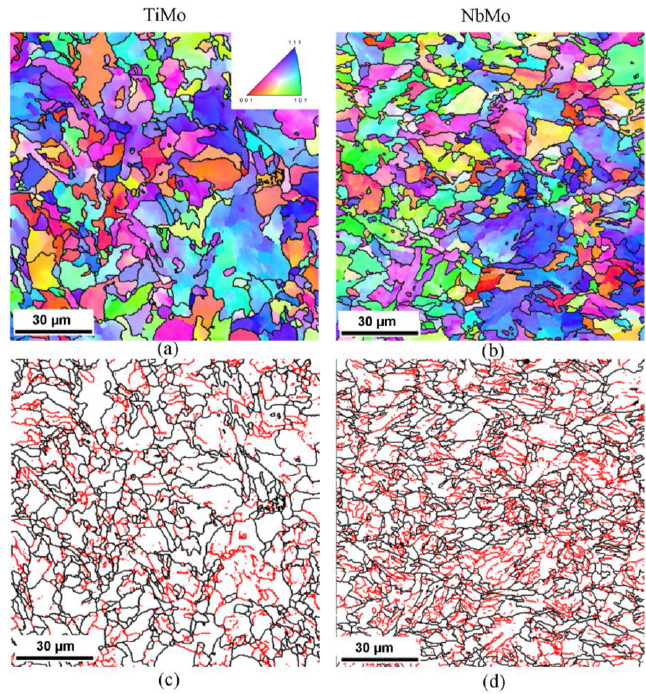
Figure 2. ( a , b ) IPF (Inverse Pole Figure) and ( c , d ) grain boundary maps obtained via EBSD in: TiMo ( a , c ); and NbMo ( b , d ) steels for a coiling temperature of 600 °C. and NbMo ( b , d ) steels for a coiling temperature of 600 ◦